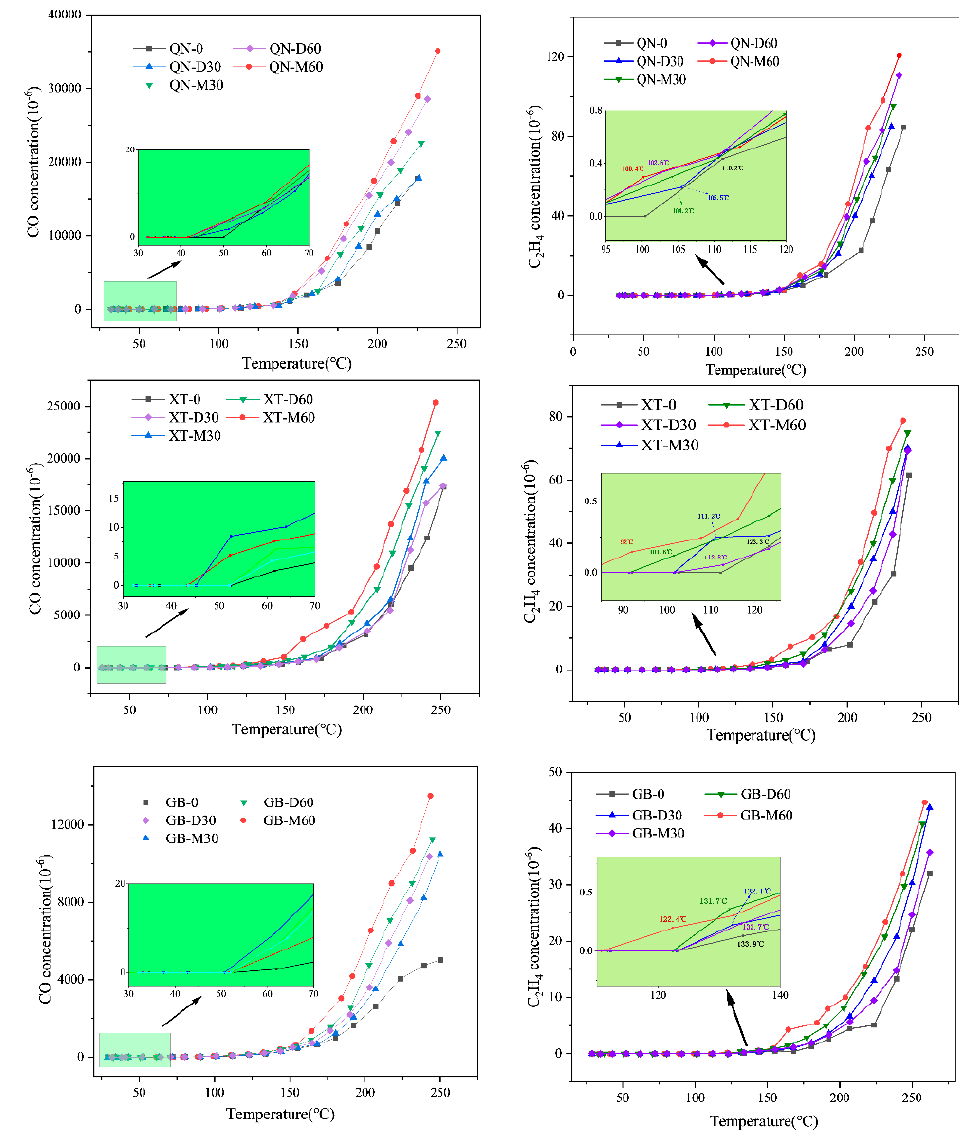
Figure 2. Curves of CO and C 2 H 4 generation with temperature during the heating of raw coal and water-soaked coal.